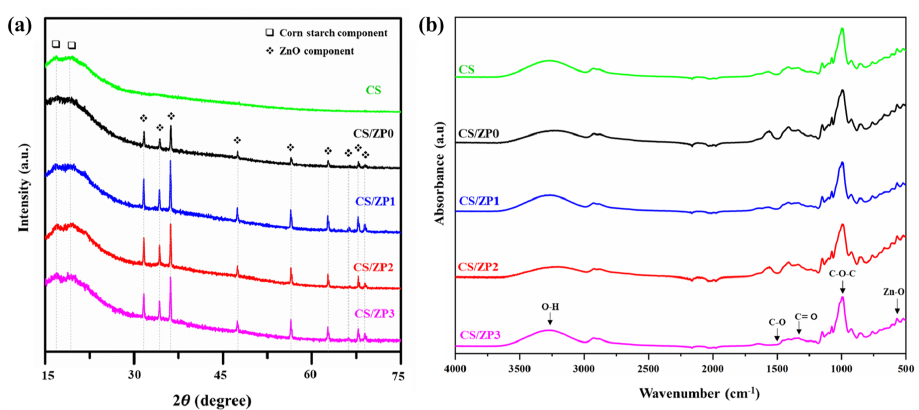
Figure 5. ( a ) XRD patterns of neat CS film and bionanocomposite film samples and ( b ) FT-IR spectra of neat CS film and bionanocomposite film samples.